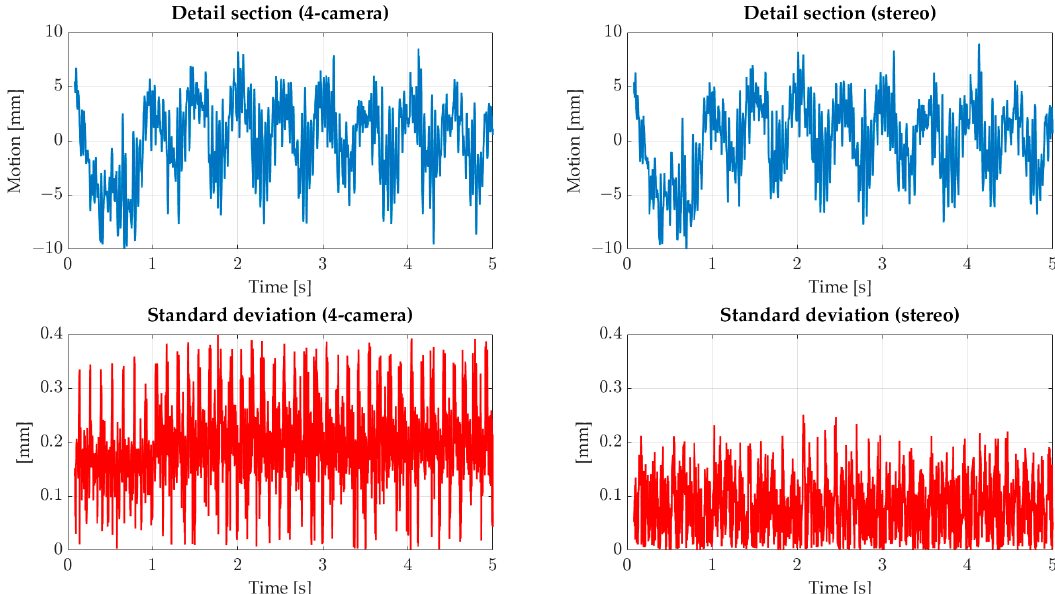
Figure 14. Detail section of motion profile by sinusoidal inflow is shown as a blue profile. The standard deviation is shown as a red profile and is balanced by the mean value. Motion and standard deviation have different scaling.